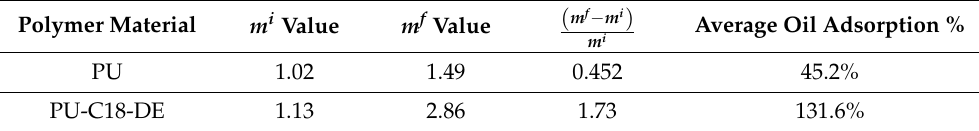
Table 3. Calculation of oil adsorption percentage to understand oleophilicity of the PU and PU-C18-DE. Polymer Material